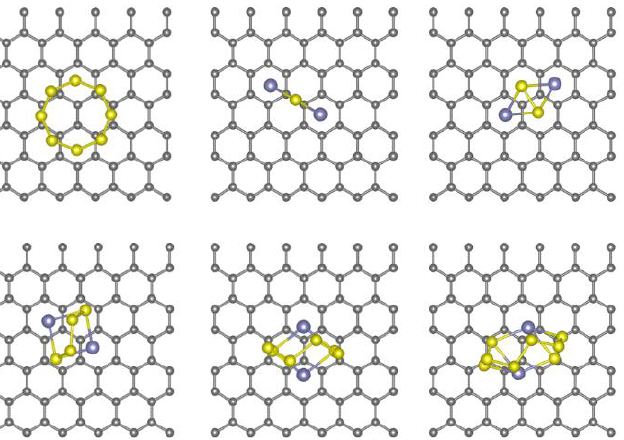
Figure 3. The optimized structures of cyclo-S 8 and Na 2 S n (n = 1, 2, 4, 6, and 8) species adsorbed on the surface of pristine graphene. The black, blue, and yellow balls represent carbon, sodium, and sulfur atoms, respectively.